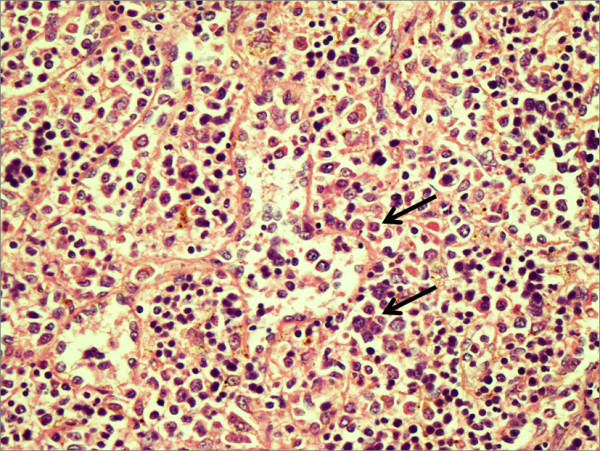
Specimen of spleen showing numerous erythroid precursors along with occasional megakaryocytes indicating an evidence of hematopoiesis (Arrow).